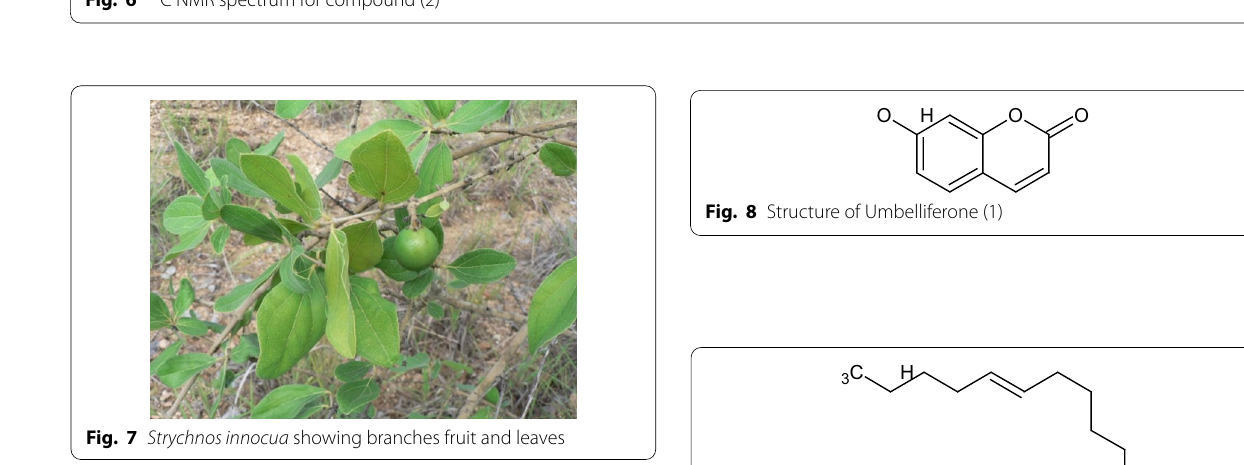
Fig. 6 13 C NMR spectrum for compound